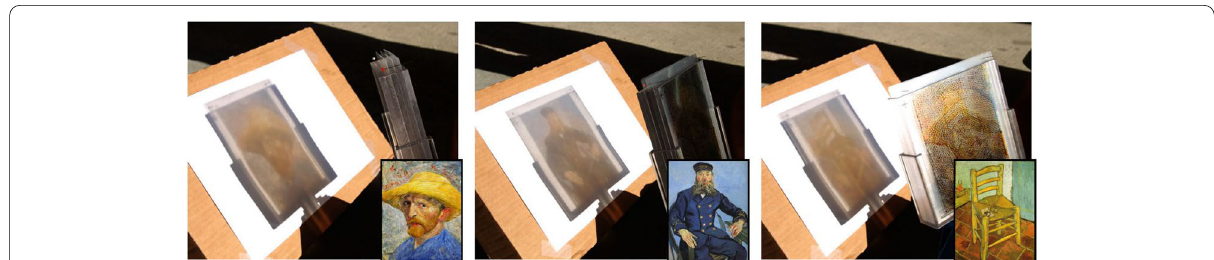
Fig. 5 Baran et al. [10] used translucent plates to fabricate shadow artworks that cast different color shadow images when placed at different orientations under